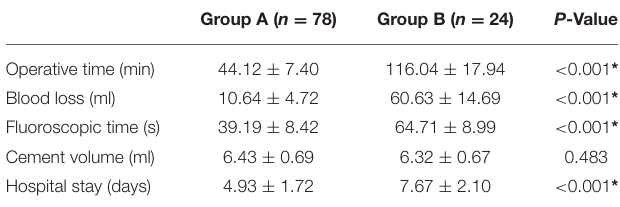
TABLE 2 | Perioperative parameters of both